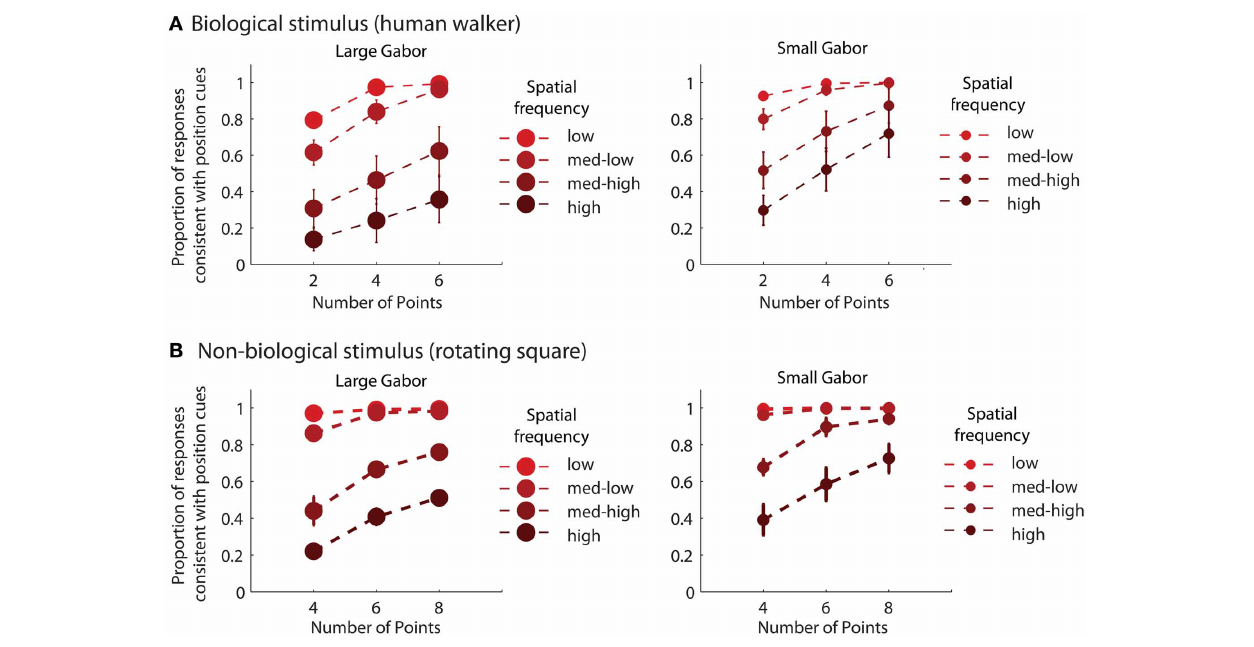
FIGURE 6 | Group-averaged results of model simulations for biological (A) and non-biological (B) stimuli. The panels from left to right show the data from conditions with larger and smaller elements, respectively, as indicated by the standard deviation of the Gaussian envelope (0.84 ◦ or 0.42 ◦ ). Different spatial frequency conditions are